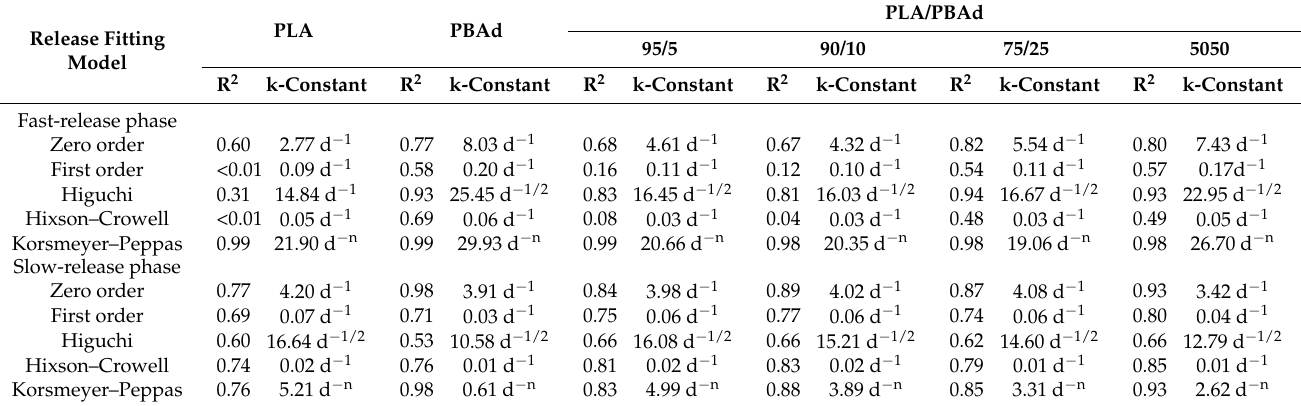
Table 5. Dissolution data model fitting results for the employed drug release kinetic